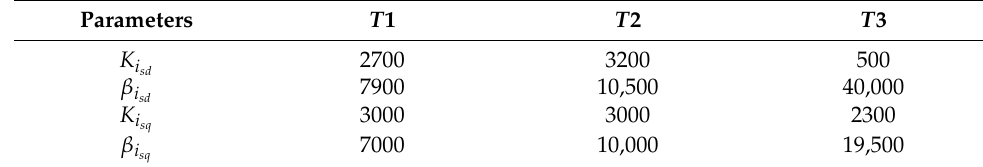
Table 1. The three turnings of the two ISMC regulators (D1 & D2 designs).